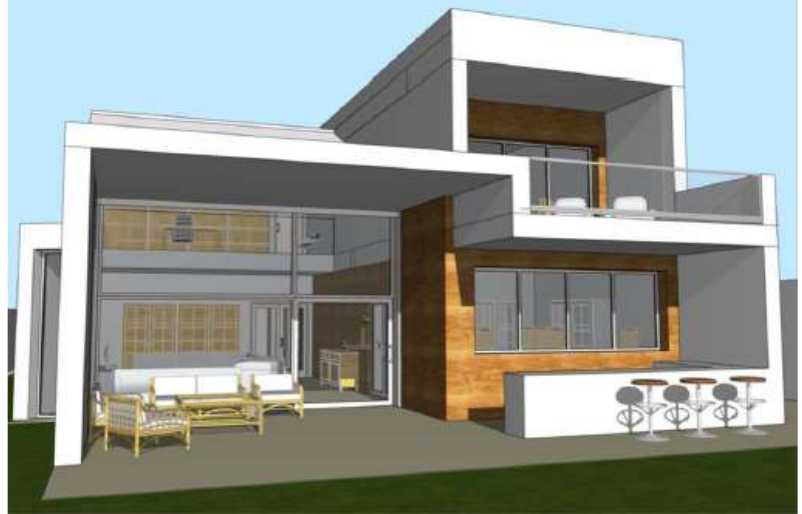
Figure 9. South elevation. Study sunlight December 21 at 2:00 p.m.